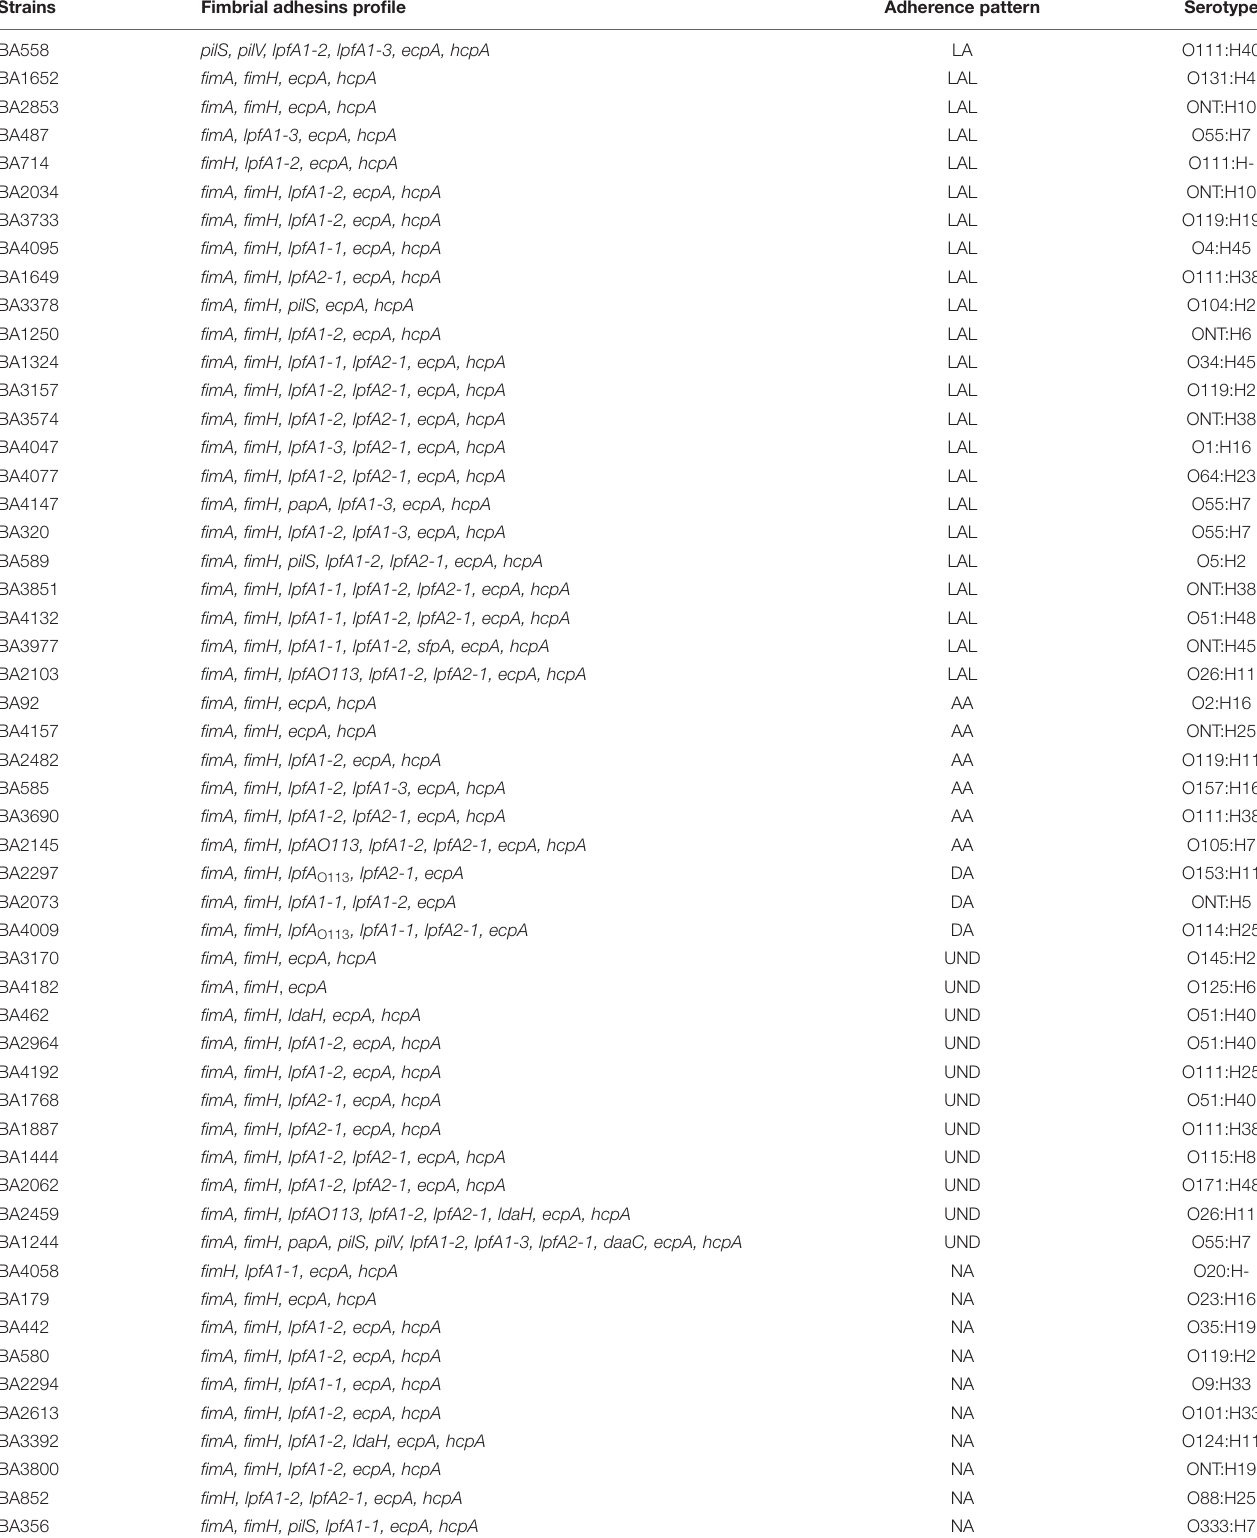
TABLE 2 | Genetic fimbrial profile of aEPEC strains. Strains Fimbrial adhesins profile Adherence pattern